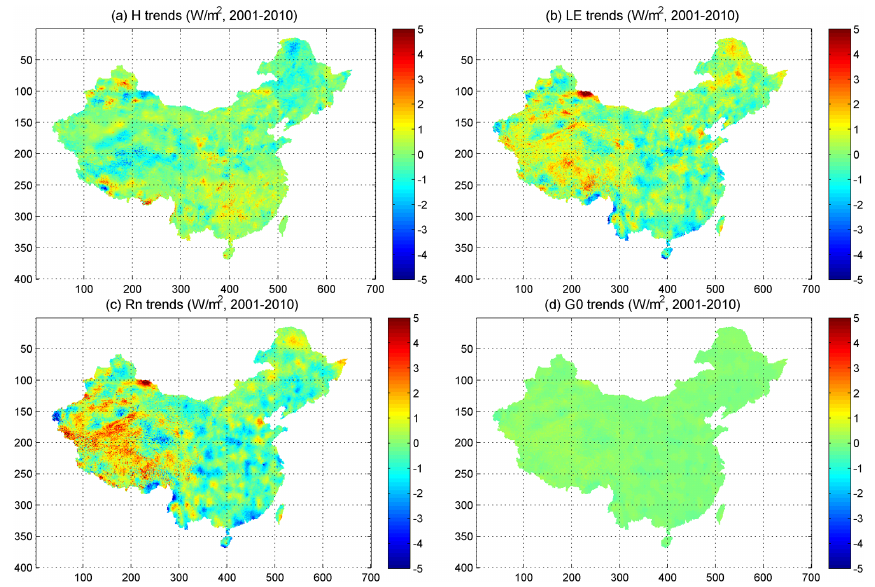
Figure 13. Spatial trends of (a) sensible heat flux ( H ), (b) latent heat flux (LE), (c) net radiation (Rn), and (d) ground heat flux ( G 0 ) on the Chinese landmass from 2001 to